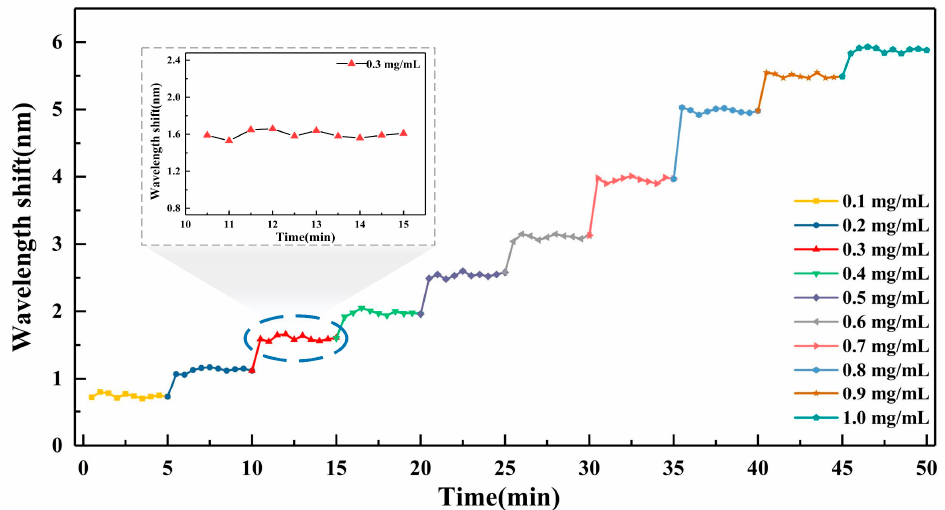
Figure 9. The real-time wavelength shift responses of microfiber in Hb detection. Inset: transmission spectral responses at 0.3 mg /